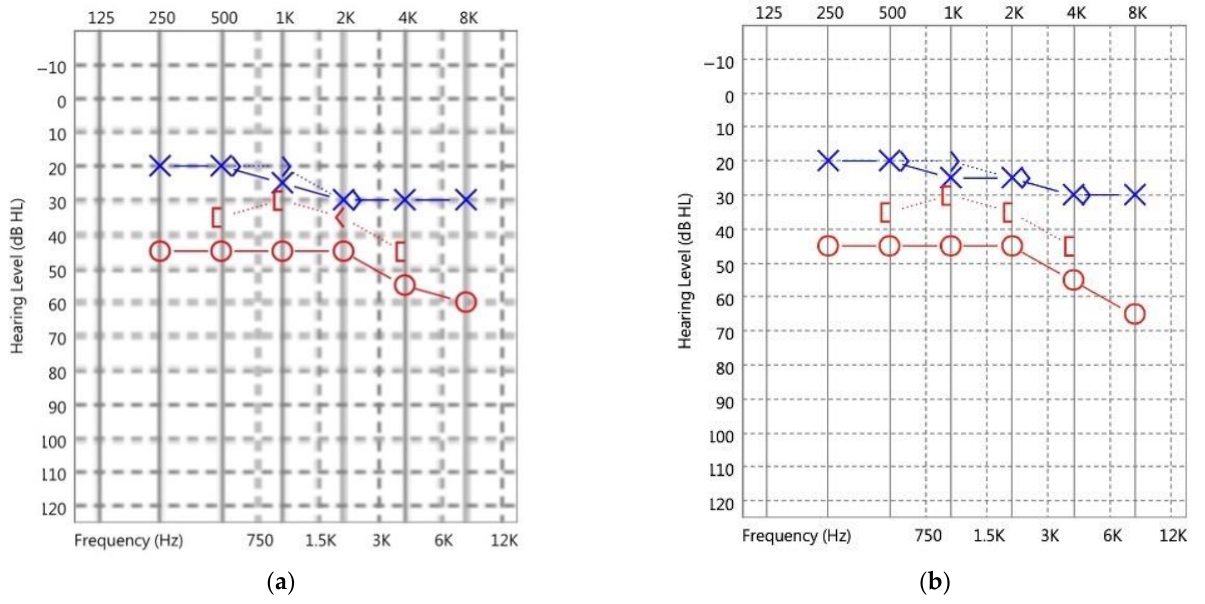
Figure 2. ( a ) Pure-tone audiometry (PTA) demonstrated mixed hearing loss in the right ear and mild sensorineural hearing loss at 2 – 8 kHz in the left ear. ( b ) After 10 years of clinical follow-up, the most recent PTA revealed stationary mixed hearing loss in the right ear. (O: unmasked air conduction of right ear, X: unmasked air conduction of left ear, : unmasked bone conduction of right ear, : unmasked bone conduction of left ear, : masked bone conduction of right ear)